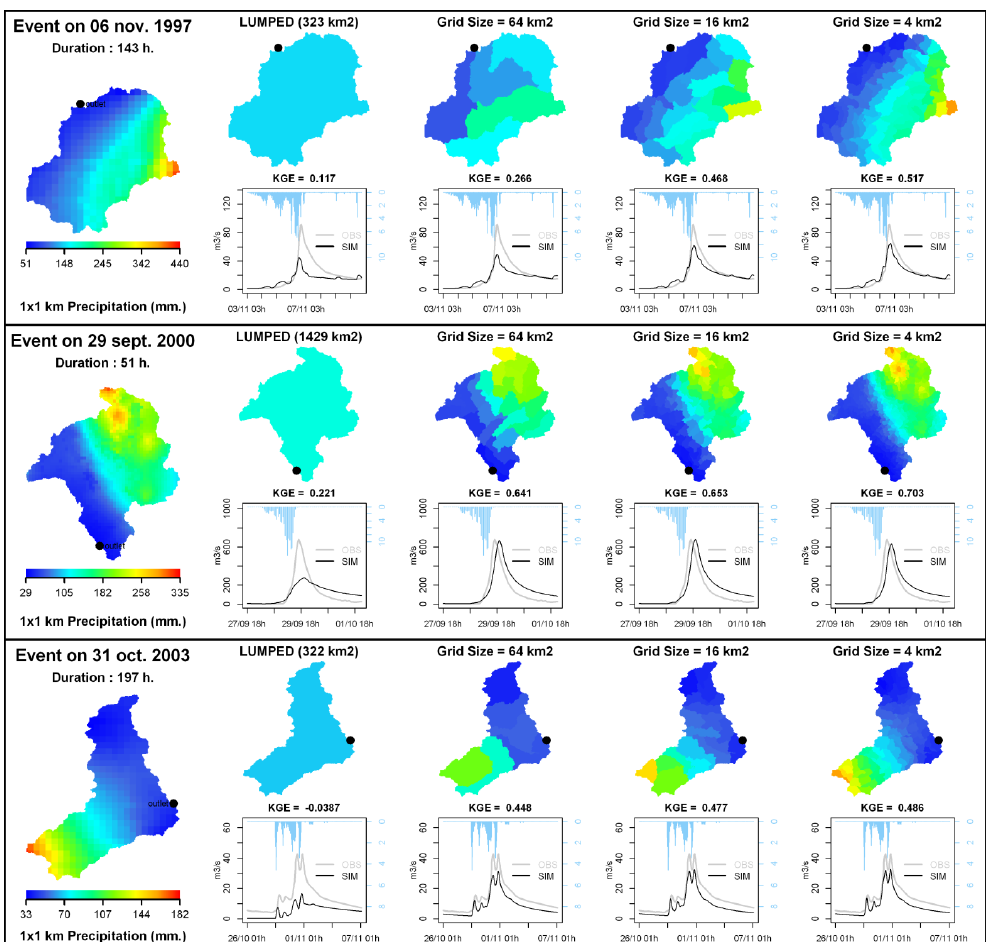
Fig. 14. Cumulated precipitation fields observed in the Cévennes and Mediterranean regions for three flood events with simulated and observed streamflow at different spatial resolutions: November 1997 flood event ( I L =1.08 and I σ =1.66) in the Allier catchment at Langogne (323km 2 ) (top panels); September 2000 flood event ( I L =1.02 and I σ =6.73) in the Hérault catchment at Gignac (1429km 2 ) (middle panels); October 2003 flood event ( I L =1.05 and I σ =0.94) in the Alagnon catchment at Joursac (322km 2 ) (bottom